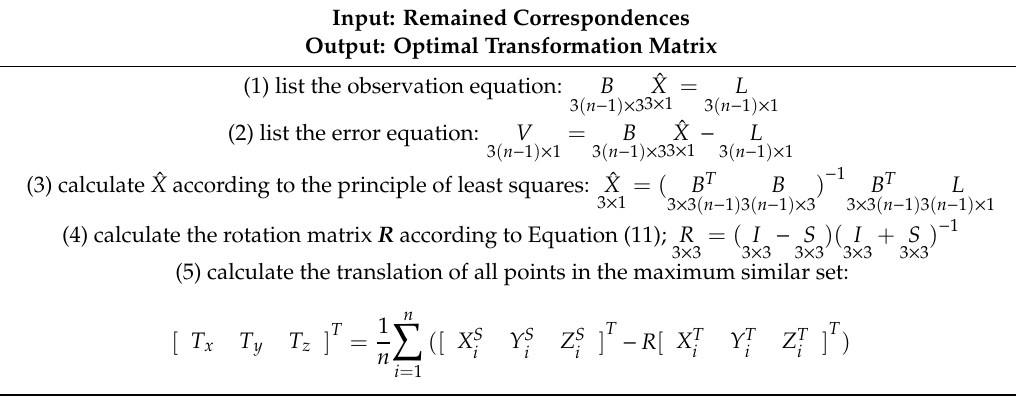
Table A3. Algorithm 3 Rodriguez-LS-based